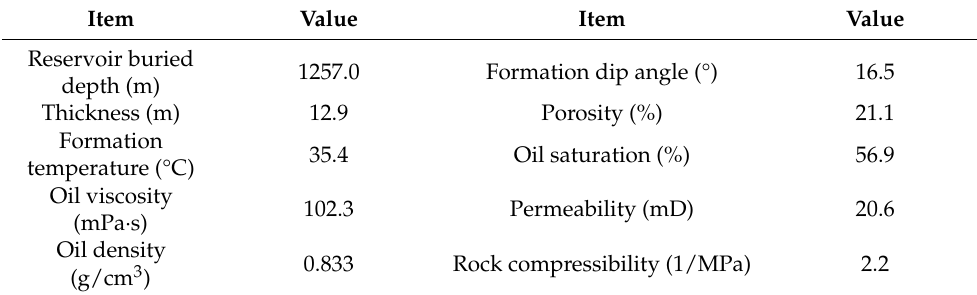
Table 1. Original reservoir parameters.